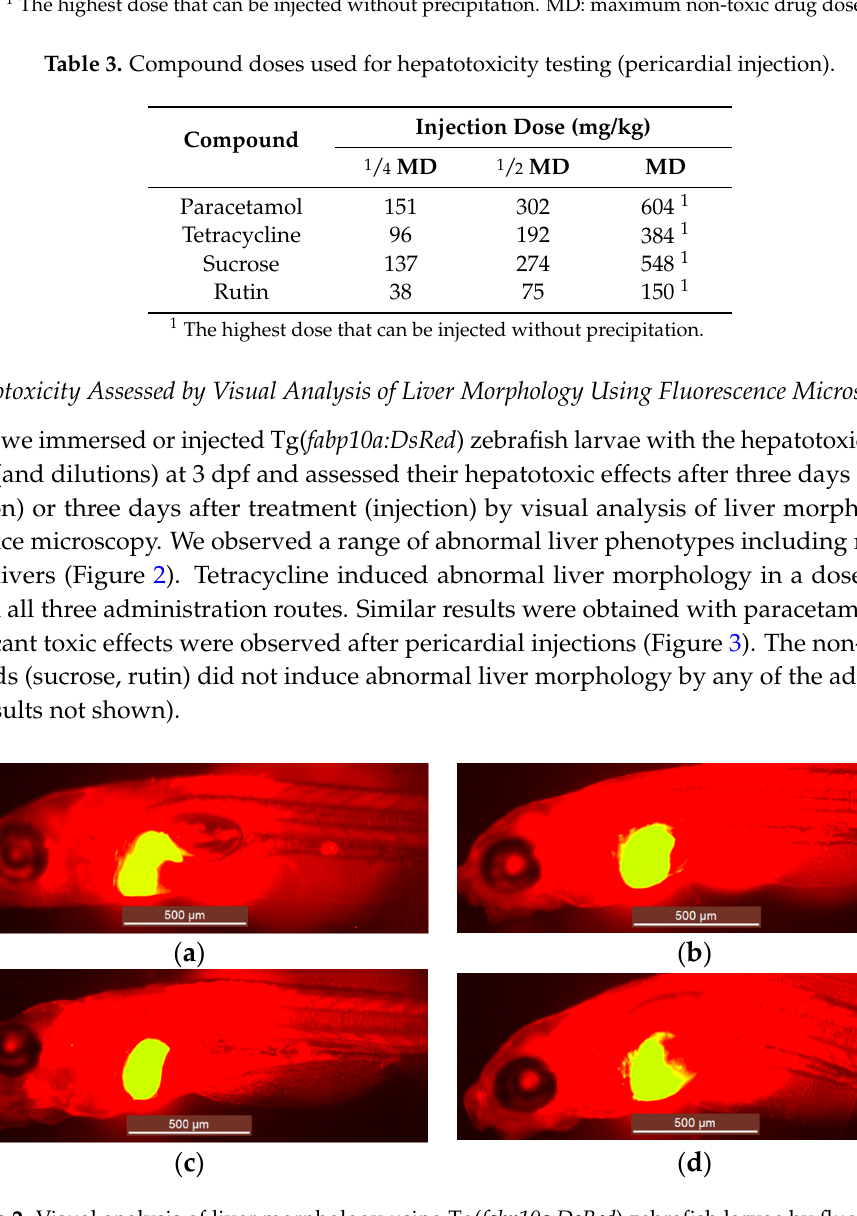
Figure 2. Visual analysis of liver morphology using Tg( fabp10a:DsRed ) zebrafish larvae by fluorescence microscopy (original 40 × magnification). Larvae with normal liver morphology ( a ); and abnormal liver morphology ( b – d ). The liver area is identified as the yellow area.